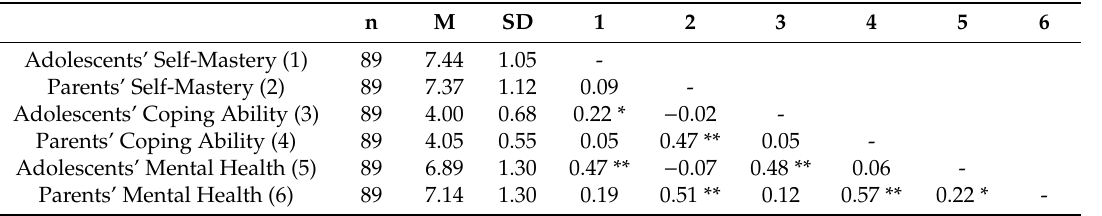
Table 2. Pearson’s Bivariate Correlations between all variables.